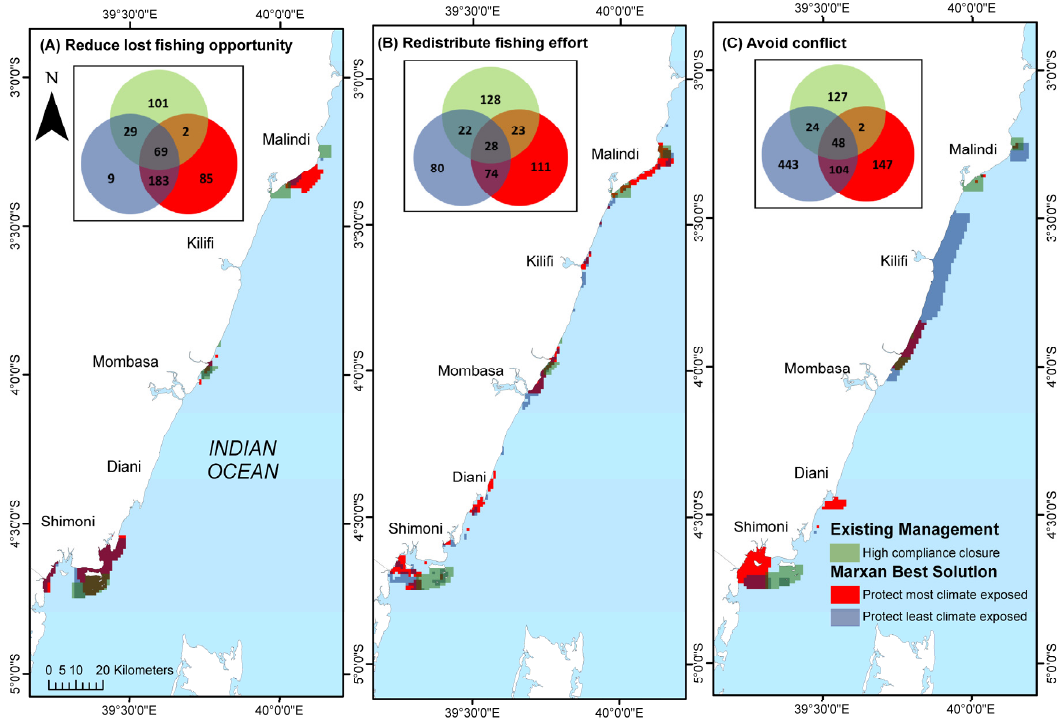
Figure 6. Conservation areas selected in the most cost-efficient scenario of 100 Marxan runs, based on prioritization analysis when ( A ) reducing the cost of lost fishing opportunity ( B ) redistributing fishing effort to minimize impacts and ( C ) avoiding potential conflicts between ocean based activities and conservation. Blue color represents priority areas when aiming to protect areas least exposed to climate change while red represents priorities when aiming to protect areas most exposed to climate change. Existing high compliance closures are shown in green. Inset venn plots show the area (number of planning units) selected under each objective, with overlapping sections representing areas which are existing high compliance closures, and which were identified as priorities when attempting to protect either the most or least exposed areas to climate change (e.g., the center of the venn plot shows the area of sites which were identified under both climate change exposure scenarios and which are existing high compliance closures).